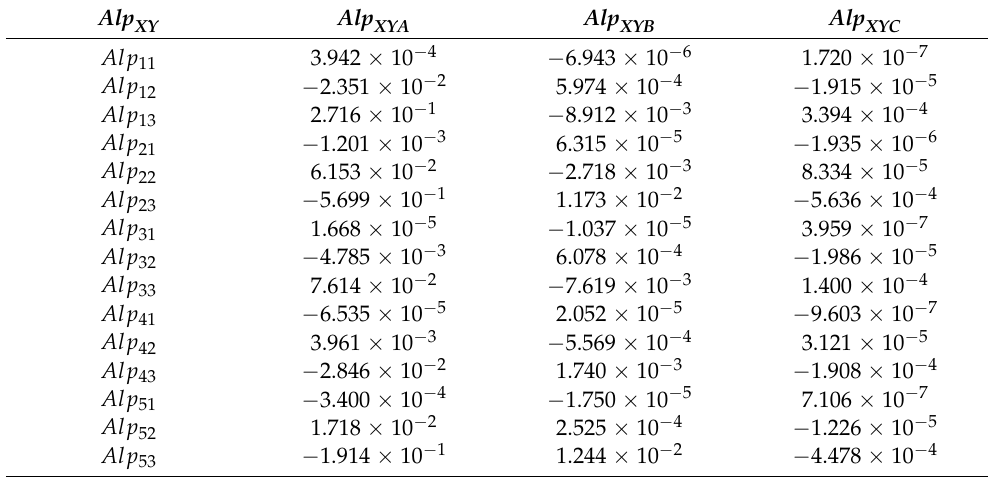
Table 8. Alp XY correlation coefficients used in morphing equations for 3D postpartum woman